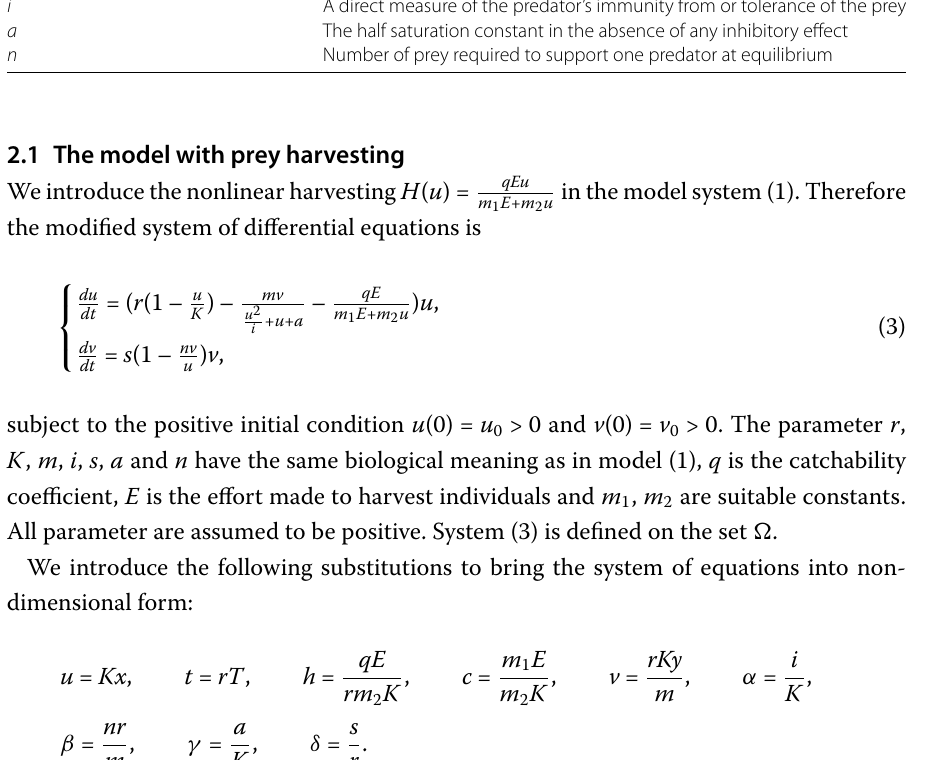
Table 1 Parameters and their biological meanings in this paper Parameter Description r Intrinsic growth rate of the prey s Intrinsic growth rates of the predator